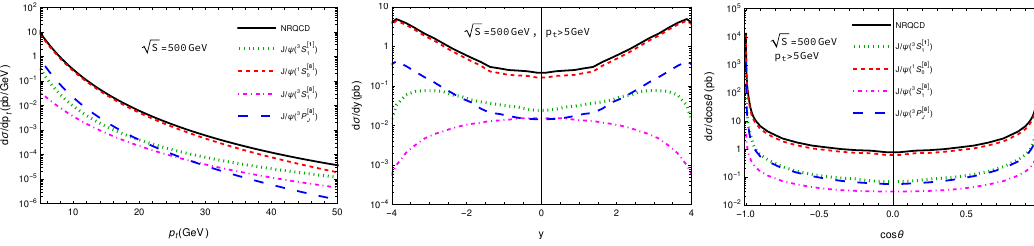
Figure 4 . Kinematic distributions for different intermediate c ¯ c states of J/ψ photoproduction at √ the ILC ( S = 500 GeV ). The y and cos θ distributions are plotted under the cut p t > 5 GeV . y curves use same legends as those of p t